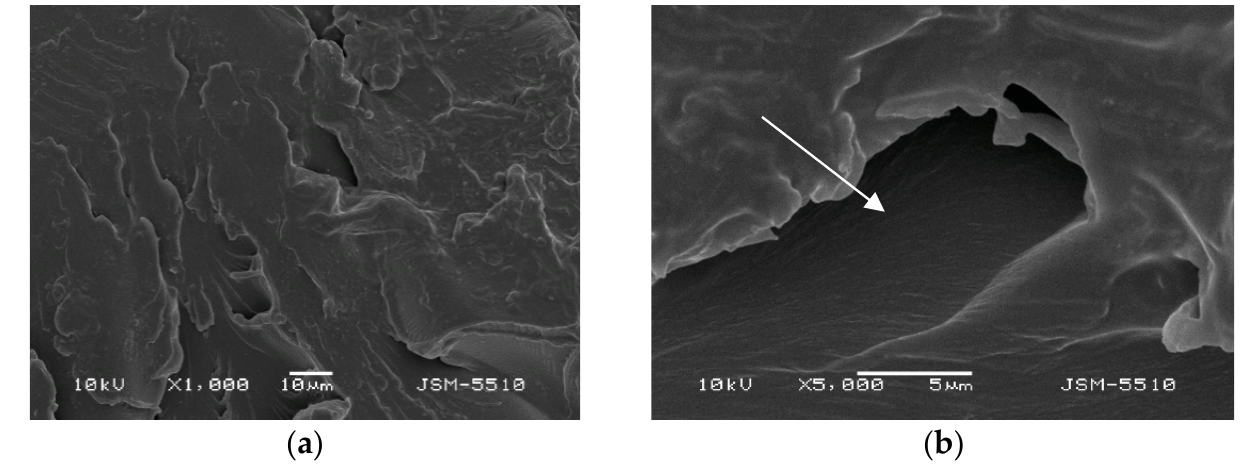
Figure 5. ( a ) BS under magnification ×1000. ( b ) BS under magnification ×5000.